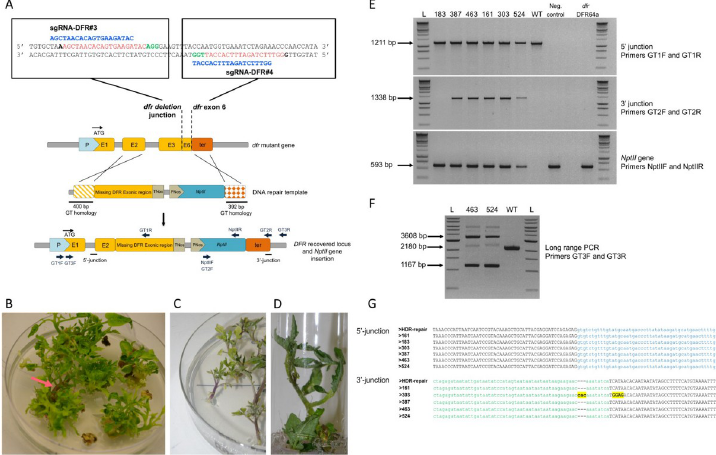
Fig 2. Targeted gene insertion at the dfr locus. (A) Schematic representation of HDR-mediated gene insertion at the dfr mutant locus using two sgRNAs: sgRNA-DFR#3 and sgRNA-DFR#4 targeting the dfr deletion junction and exon 6 (E6 yellow box). The PAM site is in green, the target sequence in red and the sgRNA in blue. The promoter and terminator sequences are represented with pale blue and orange boxes respectively (P and Ter). Gene targeting (GT) homologous sequences are shown with boxes with a hatched pattern. The NptII gene insertion is represented by a blue box. The primers used for detection and sequencing are shown as dark blue arrows. (B) Regenerating explants on kanamycin selective media after Agrobacterium transformation of the T2 plant DFR64a with a single binary vector carrying two sgRNAs and a DNA repair template containing the DFR sequence and NptII gene. The purple coloured events can be visually identified (red arrow) (C) Purple coloured plantlets regenerating on kanamycin-containing media (D) In vitro regenerated T0 plants with HDR-mediated-gene targeting in the DFR landing pad isolated in a tube. (E) PCR analysis for the detection of the precise HR with the repair template at the 5’ junction, 3’ junction and the presence of the NptII gene with primers GT1F and GT1R in six T0 plantlets which showed anthocyanin pigmentation. WT: wild-type; Neg. control: negative control green plantlet; dfr DFR64a: deleted dfr mutant used for the HDR- mediated experiment; 183, 387, 463, 161, 303 and 524: in vitro samples from T0 plantlets issued from targeted insertion events visually screened for their anthocyanin pigmentation. (F) Long range PCR with primers GT3F and GT3R on two different targeted insertions. WT: wild-type; 463 and 524: samples from T0 plantlets from event number 463 and number 524 (with anthocyanin pigmentation). (G) Sequencing of the 5’ and 3’ junctions at the DFR locus in T0 plantlets with recovered anthocyanin pigmentation for events 161, 183, 303, 387, 463 and 524. The sequence of the 3’ junction was not obtained for event number 183. Coloured lower-case letters indicate the end and the beginning of the homologous sequence used in the DNA donor template. Black upper-case letters show the genomic sequences surrounding the insertion. Mutations in the sequences compared to expected sequence are shown with yellow boxes and bold